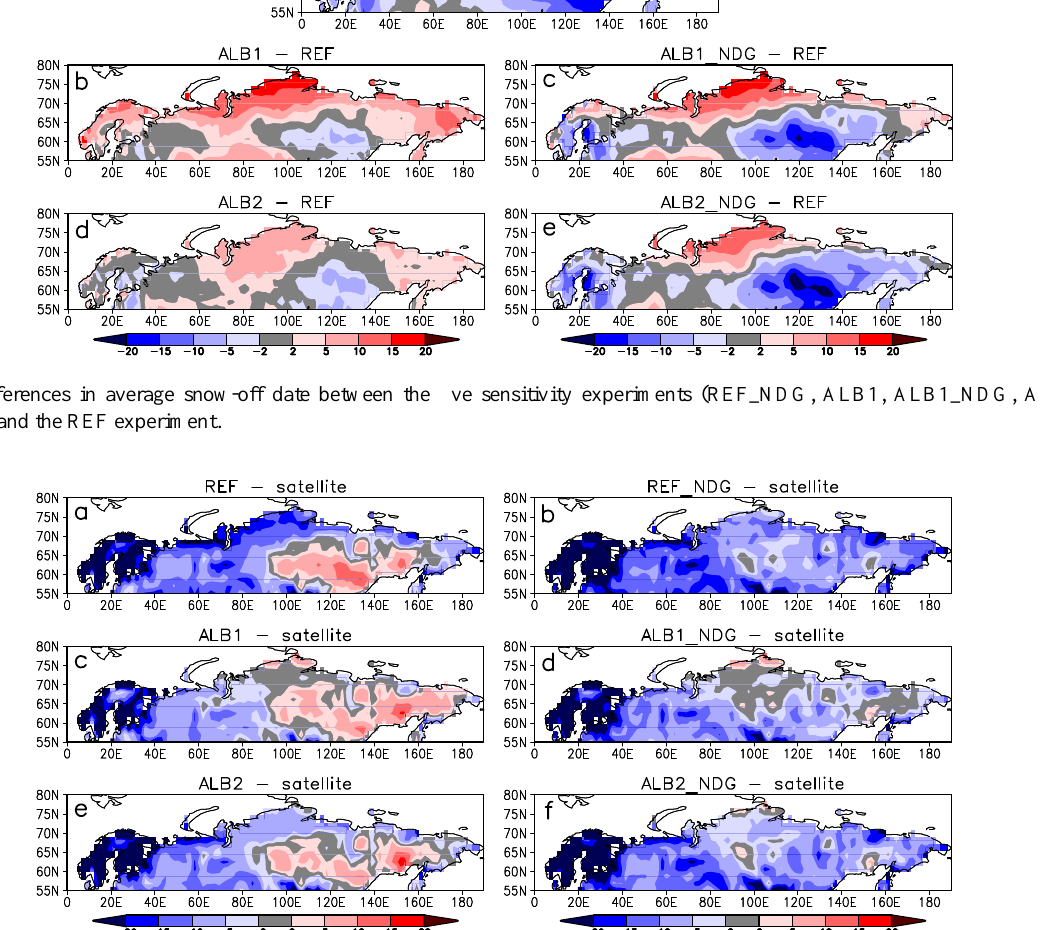
or even positive differences (i.e. delayed snow-off) appear in the Taymyr